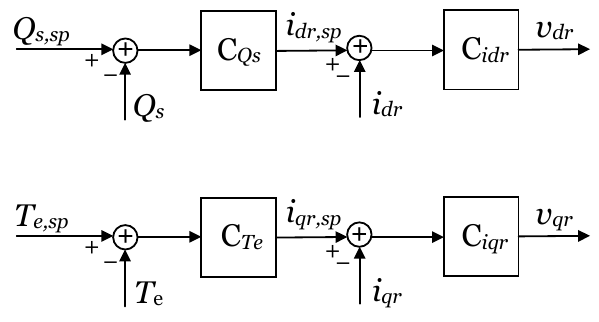
Figure 5. Schematic diagram of the rotor-side converter (RSC)